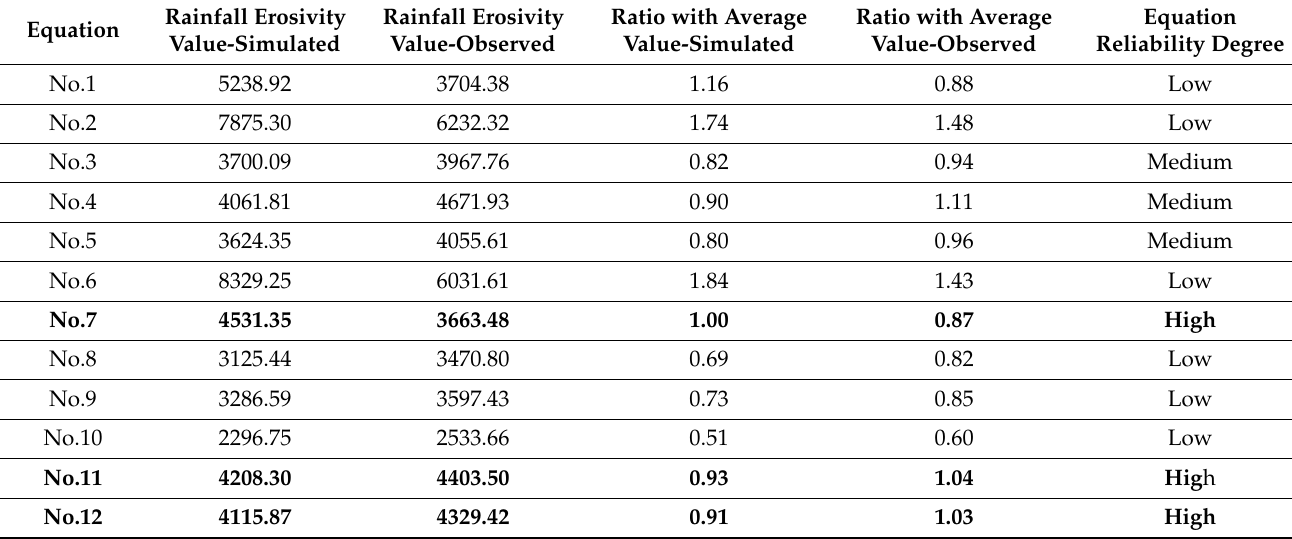
Table 2. Equation reliability degree based on rainfall erosivity values using simulated and observed rainfall for rain gauge station Colli sul